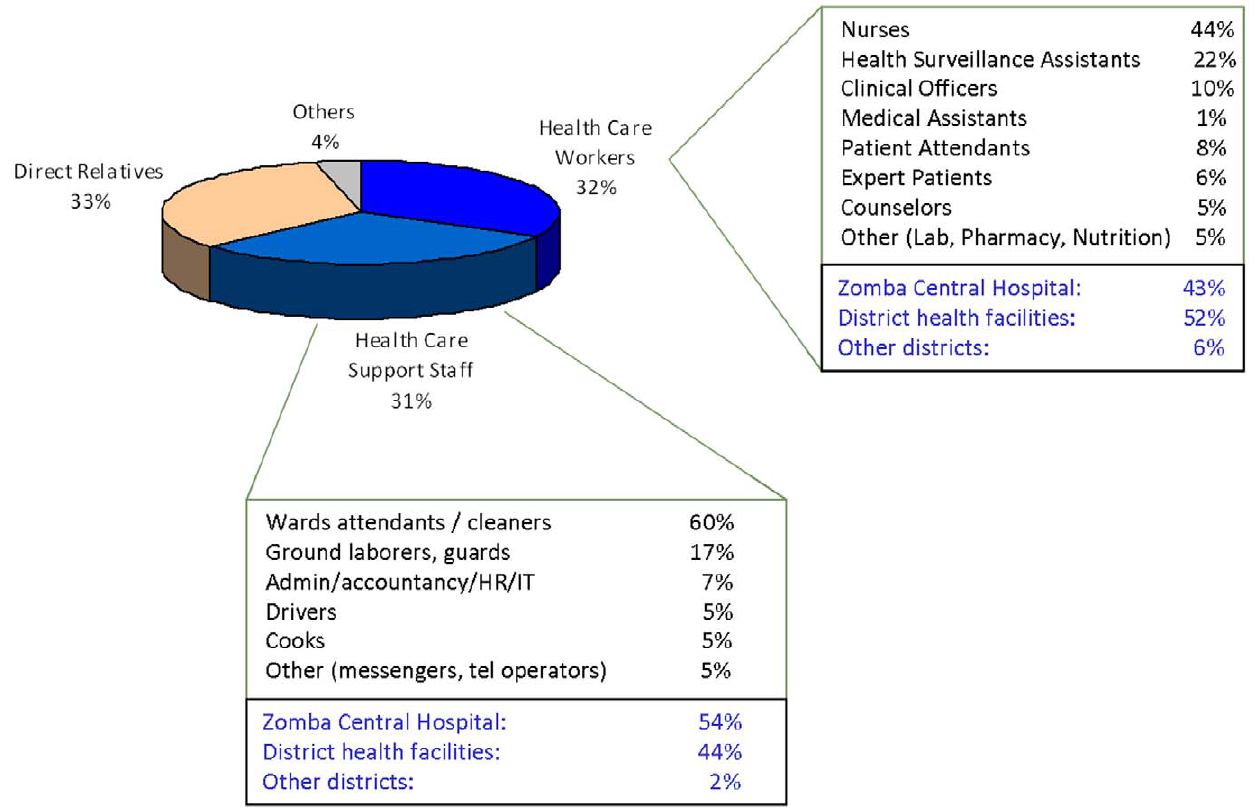
Figure 1. Occupational characteristics of ART patients in HCW clinic.